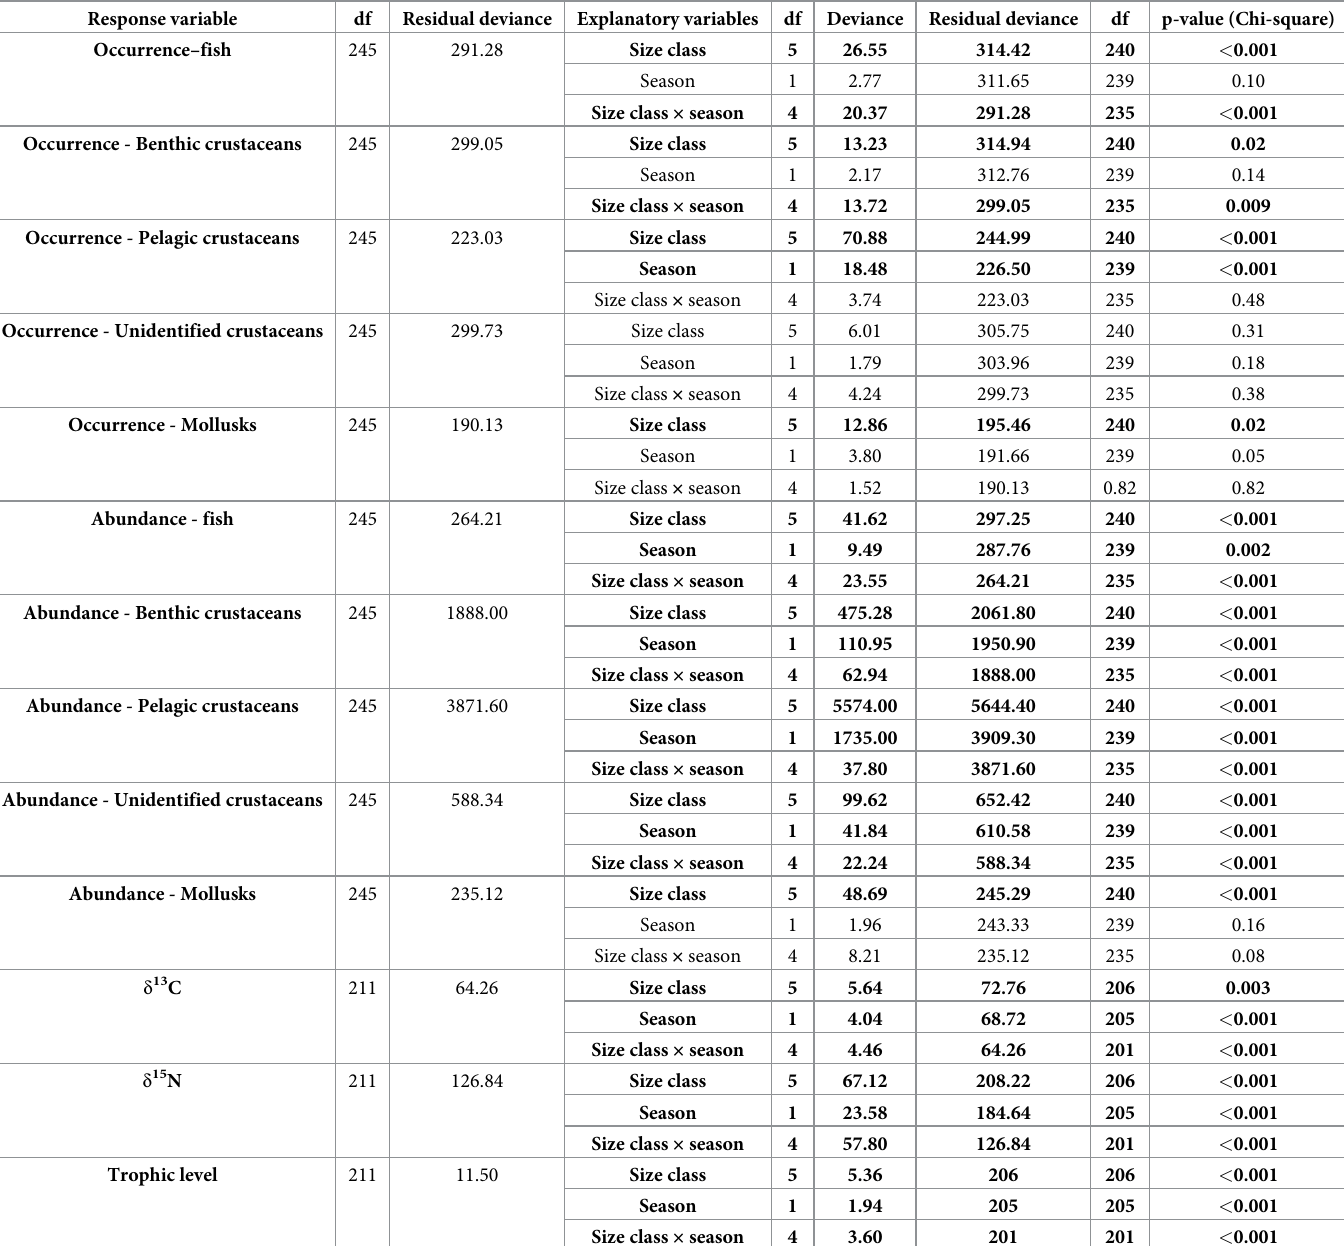
Table 2. Results of generalized linear model (type